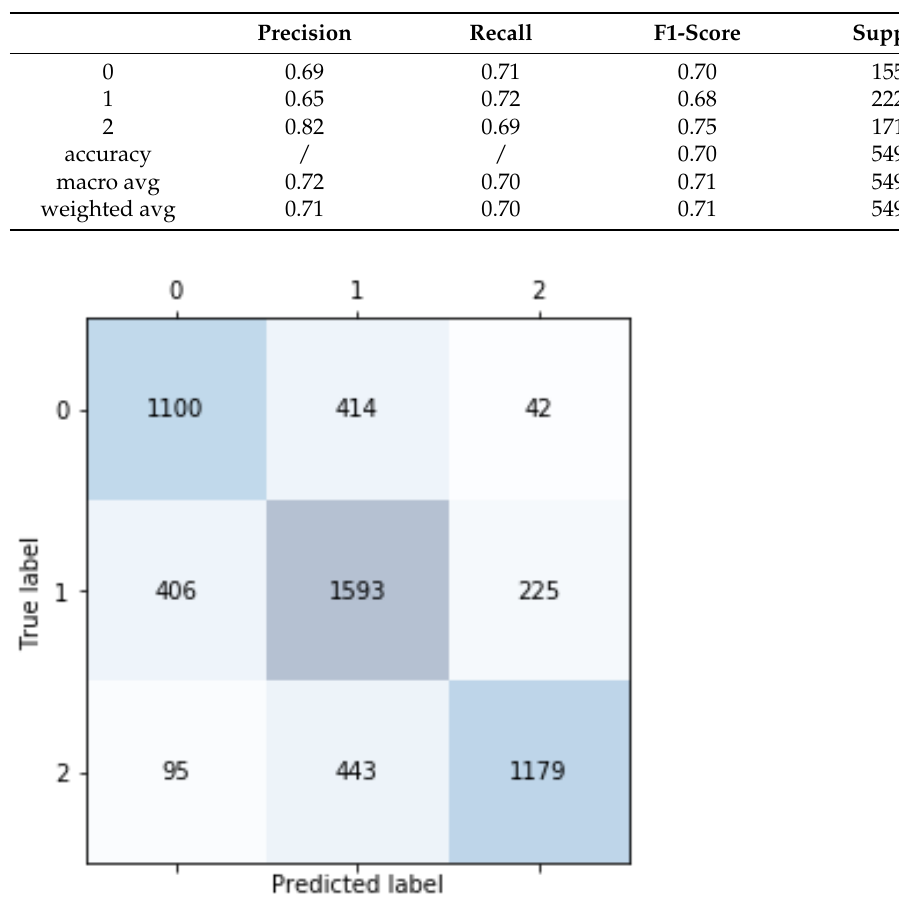
Table 5. CNN- LSTM classification_report. Table 5. CNN-LSTM classification_report.